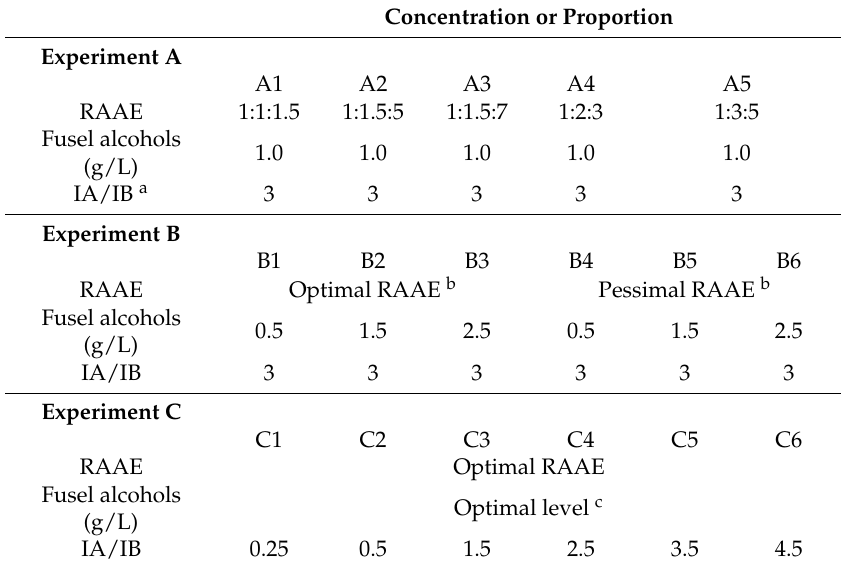
Table 2. Composition, concentration, and proportion of FLs designated for three